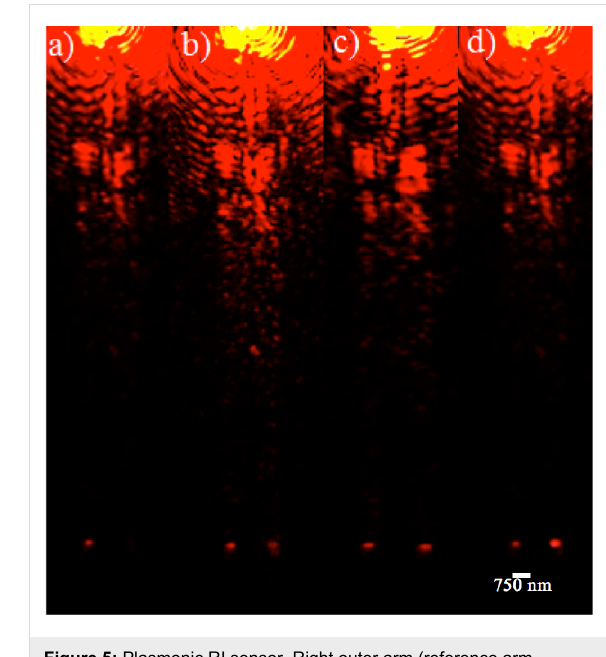
Figure 5: Plasmonic RI sensor. Right outer arm (reference arm – covered with PMMA), left outer arm (sample arm – covered with 0.5% sucrose in DI water). Rightmost to left are series of CCD images obtained for 0%, 10%, 80% sucrose in DI water and index matching oil.